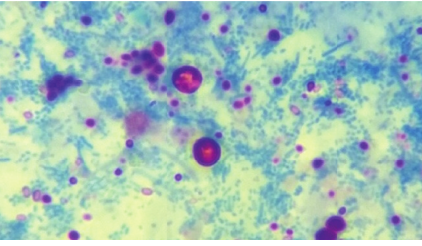
Figure 9: Non-bile-stained ovum of hookworm with segmented embryo inside on normal saline wet mount, under high power.